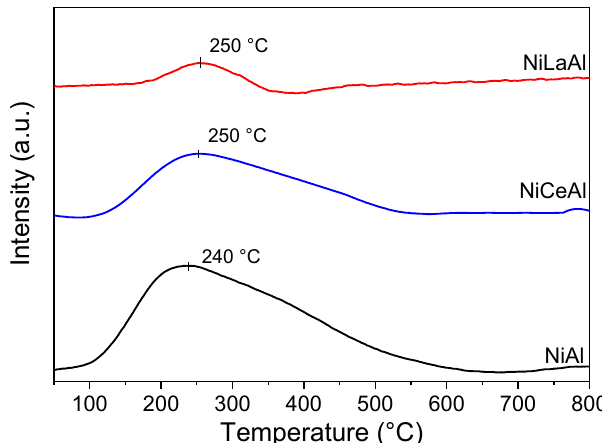
Figure 4. TPD-NH 3 profiles of reduced catalysts.